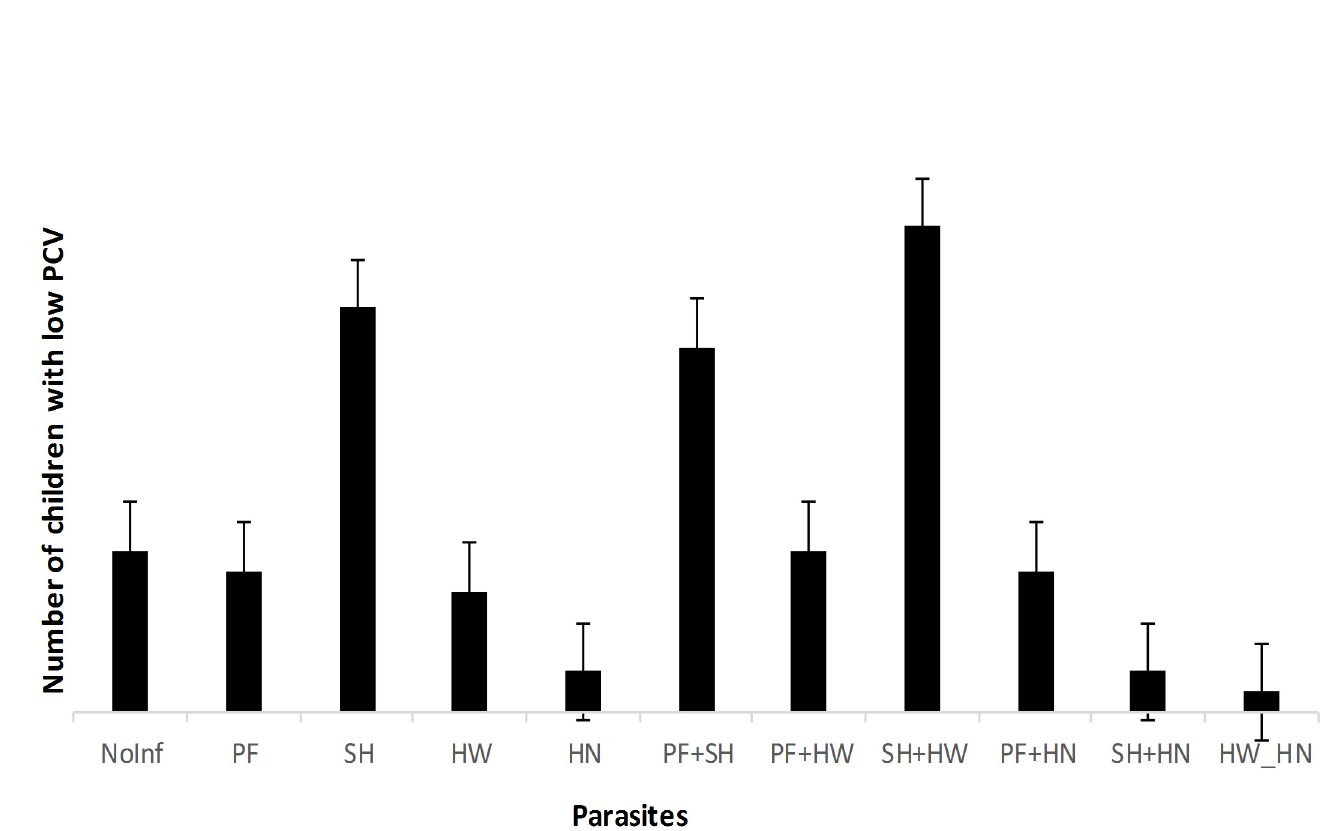
Fig 2. The proportion of children with anemia by type of infection. Key: PF = P . falciparum ; SH = S . haematobium ; HW = Hookworm; HN = Hymenolepis